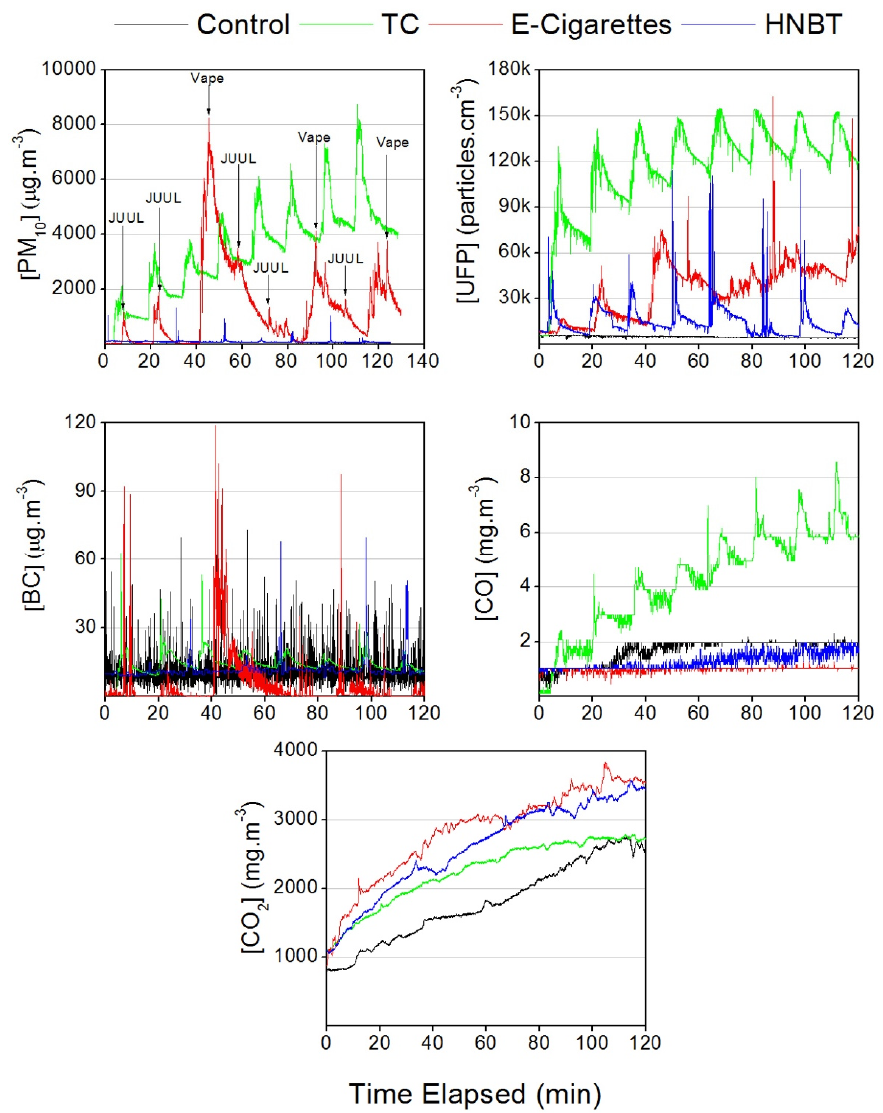
Figure 4. Temporal trends for the PM 10 , UFP, BC, CO and CO 2 measured during Traditional Cigarettes (TC), e-cigarette and Heat-not-burn tobacco (HNBT) consumption in the home.